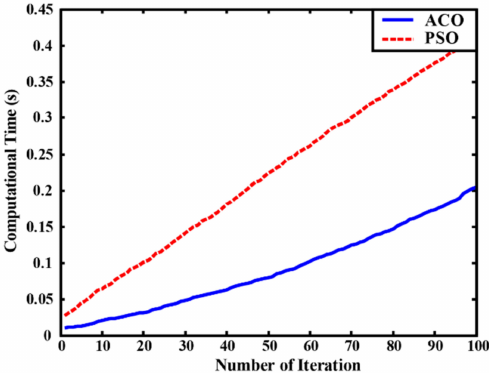
Figure 15. Computational time of the ACO and PSO algorithms.